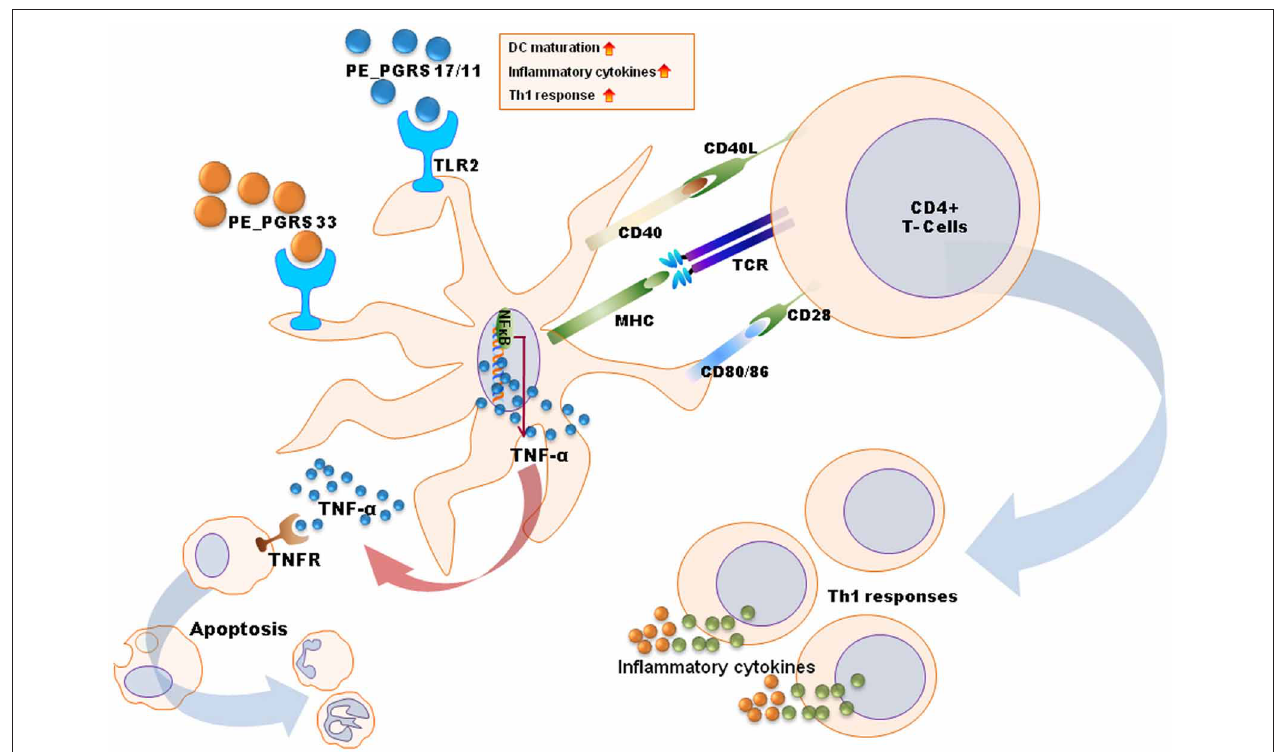
FIGURE 2 | A schematic diagram for mechanisms of dendritic cell maturation/activation to stimulate T cells by mycobacterial antigens. PE_PGRS proteins activate dendritic cells through TLR2-MAPK-NF- κ B signaling pathways. PE_PGRS 33-induced TNF- α by dendritic cells induces